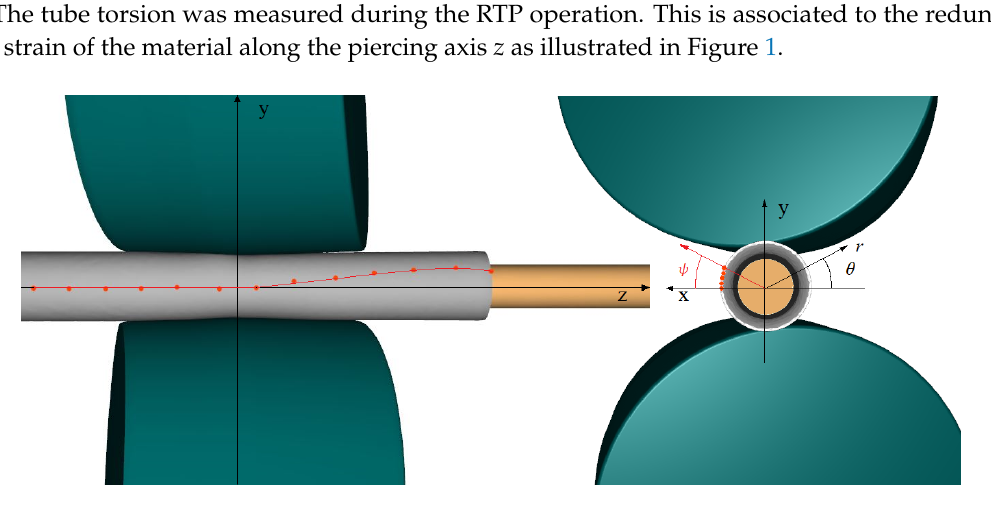
Figure 1. Measure of the shear strain component of